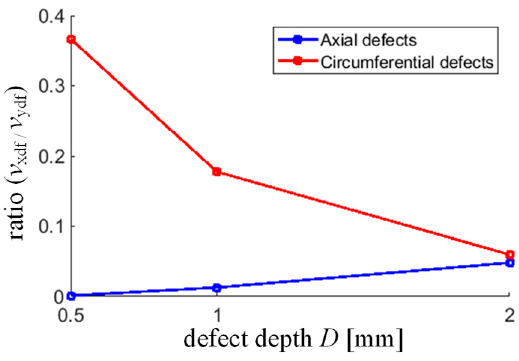
Figure 19. Results of defect depth evaluation based on the ratio of v xdf and v ydf .